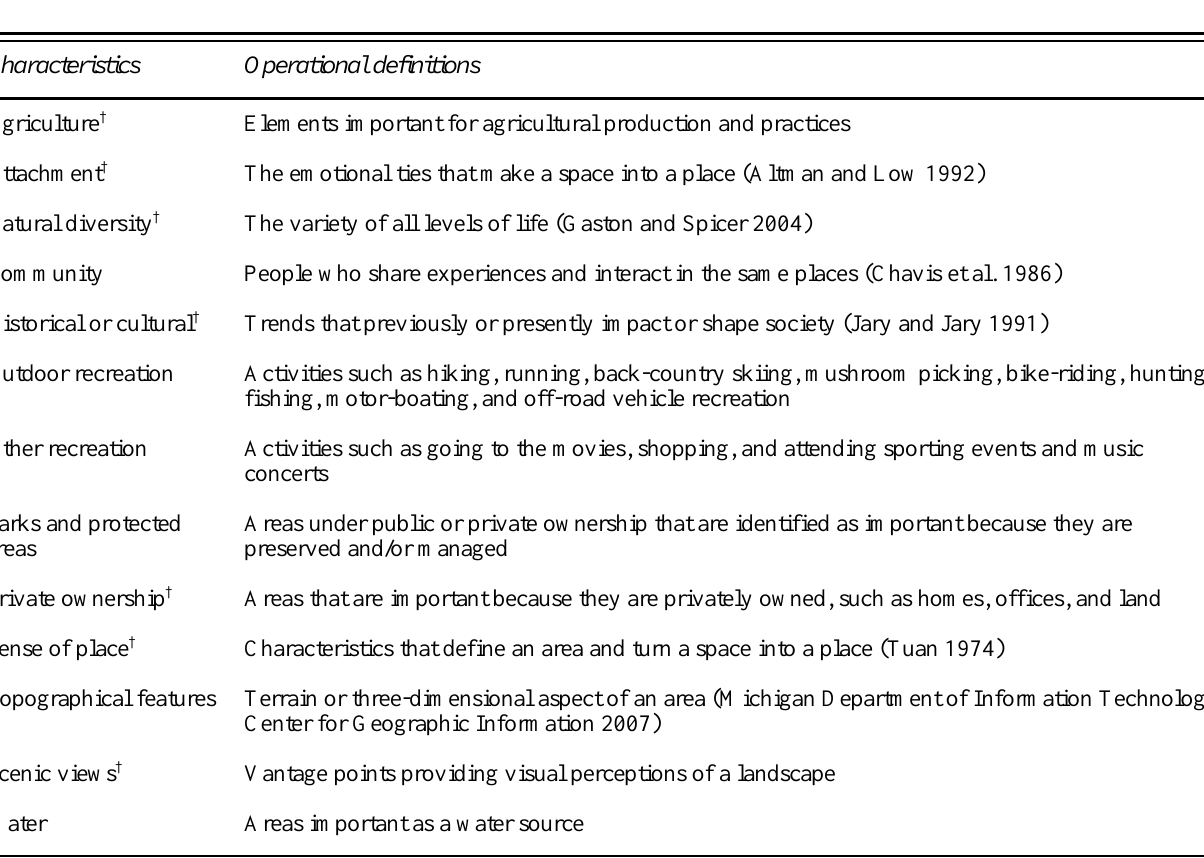
Table 6 . Operational definitions for meaningful place